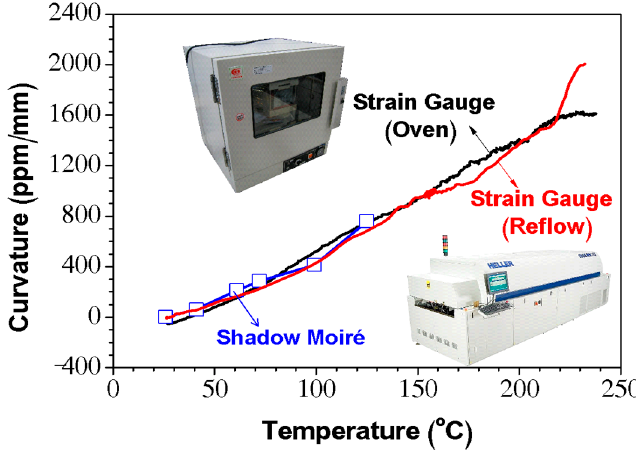
Figure 6. Experimentally obtained curvature variation of the Cu/core bi-material specimen with temperatures, obtained from strain gauges and shadow moiré in both conventional and IR reflow ovens.